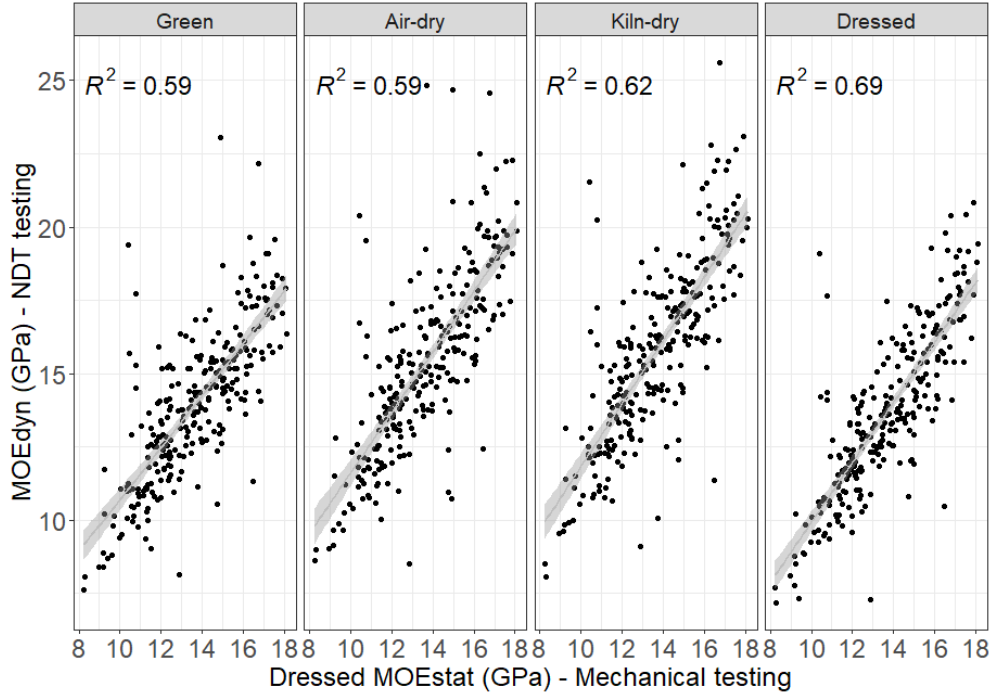
Figure 2. Relationships between MOE dyn of boards (NDT measure) at the green, air-dry, kiln-dry, and dressed stages with the MOE stat (mechanical testing) of the dressed boards.